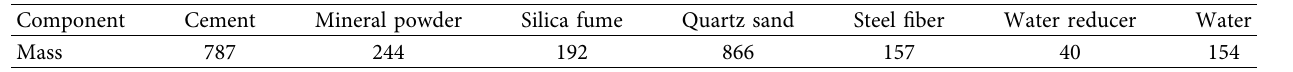
Table 2: Te mix ratio of the UHPC matrix (unit: kg/m 3